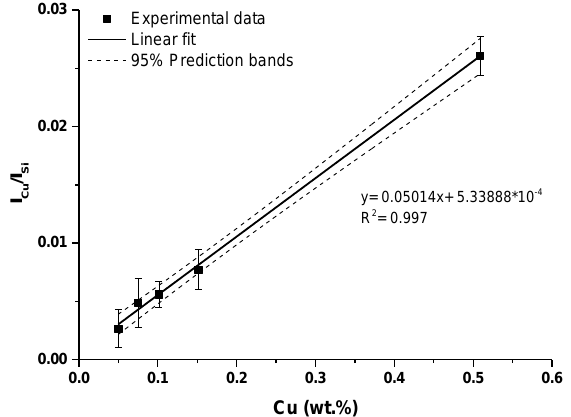
Figure 7. Calibration curve of copper obtained using Cu I: 515.32 and 521.82 nm lines (error bars represent relative standard deviation (RSD) of used data).